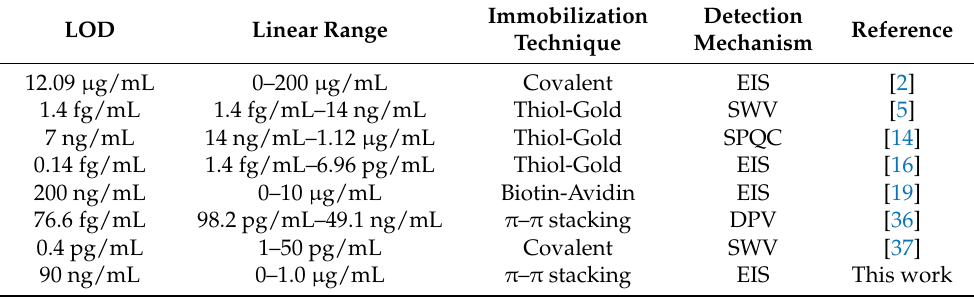
Table 2. Comparison of the sensing performances of recently published lysozyme